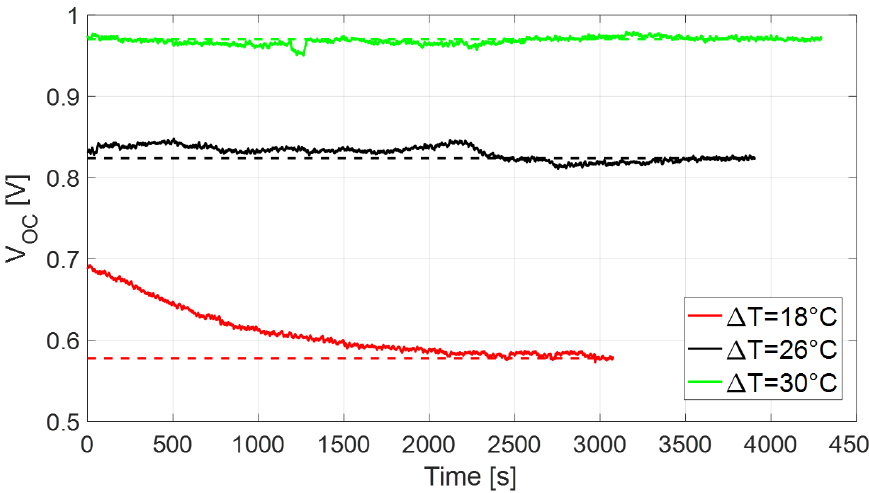
Figure 2. OC voltage of the adopted TEG at three different temperature gradients ∆ T = 18 °C (red plot), ∆ T = 26 °C (black plot) and ∆ T = 30 °C (green plot). The dashed lines are the OC voltage values after stabilization of the